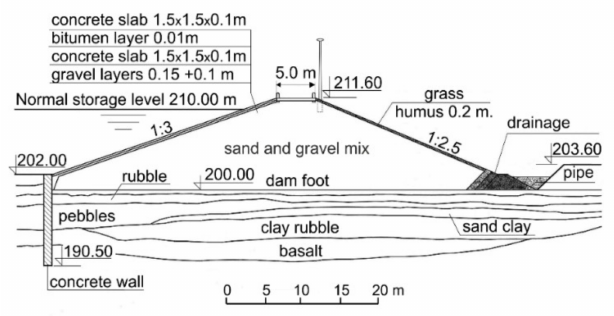
Figure 4. Cross-section of the earth